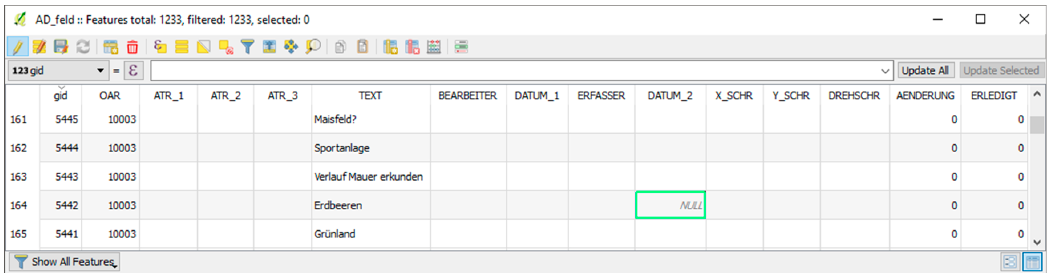
Figure 7. Template schema AD_feld with partial data.